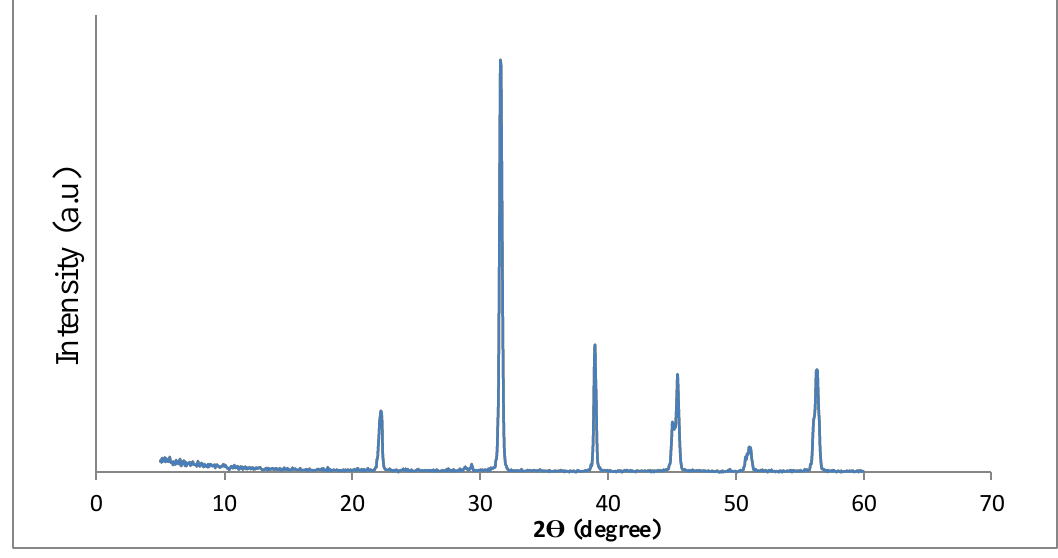
Figure 8: Barium Titanate XRD pattern at 1100 ° C. The first notice indicates that the lattice of the studied structures, at first cubic has undergone a low tetragonal distortion. The second corresponds to increased tetragonal deformation. With increasing temperatures the crystallinity of the sample increases, and in the absence of tetragonal deformation, the width of the XRD peaks should decrease. With the recorded patterns, it is not possible to quantitatively distinguish the peaks broadening because of the size of crystallites from the effect of tetragonal deformation.